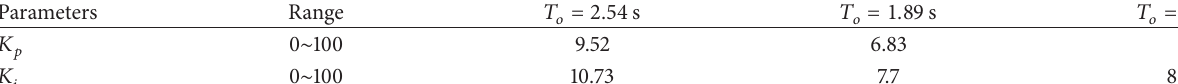
Table 3: Identification results using GA-PSO algorithm.